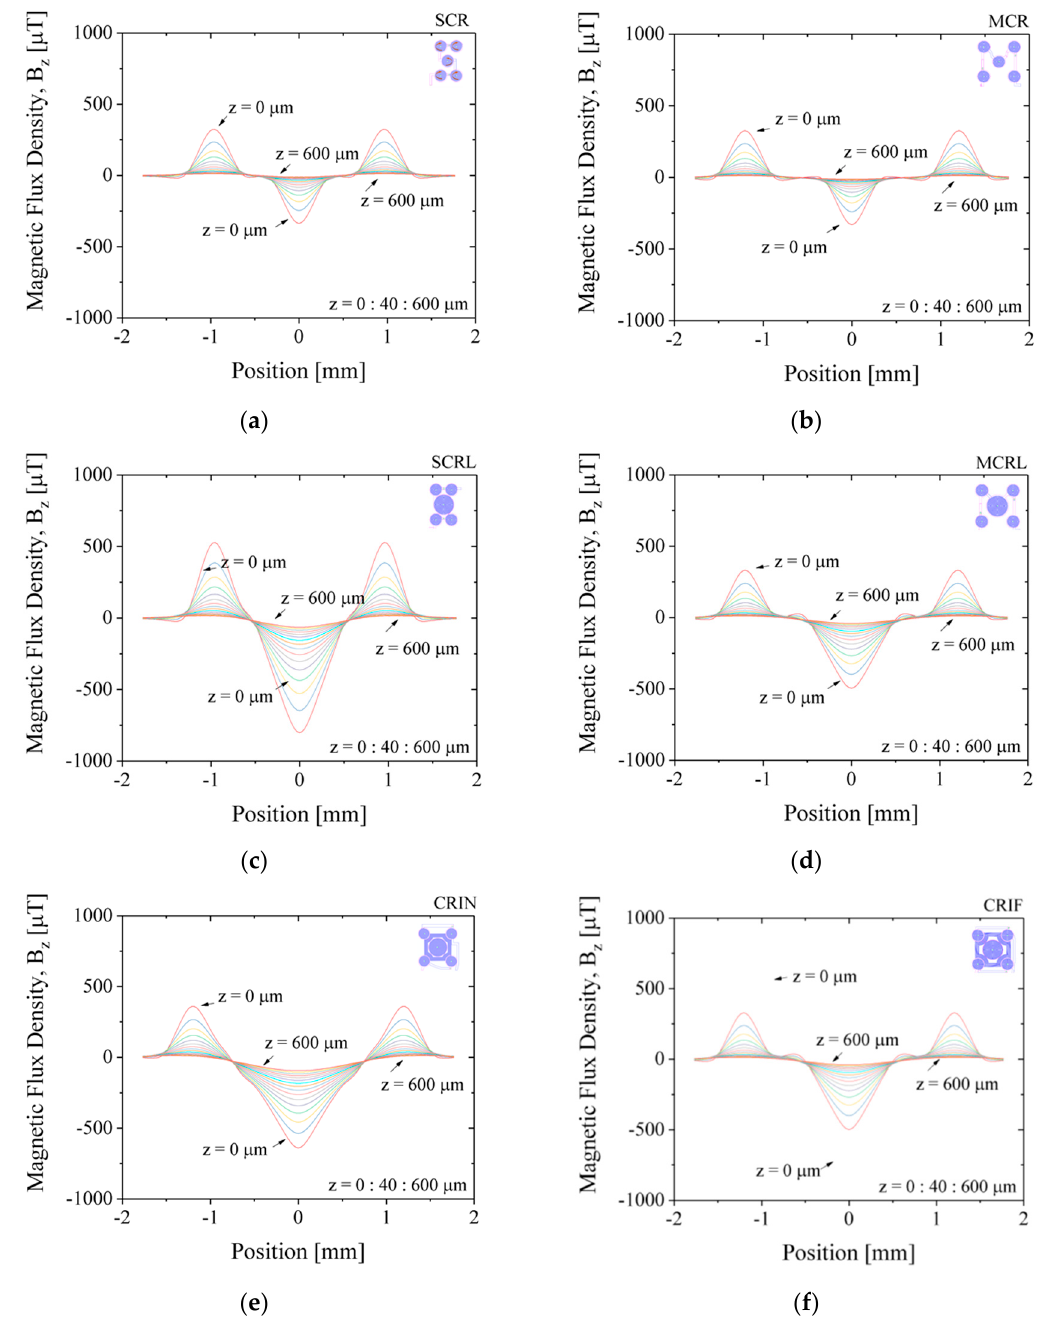
Figure 7. Simulated results for magnetic flux density, Bz , along the diagonal of the chip, for z -position varying from 0 to 600 µm in 40 µm steps. Applied current of +30 mA. ( a ) SCR, ( b ) MCR, ( c ) SCRL, ( d ) MCRL, ( e ) CRIN, ( f ) CRIF